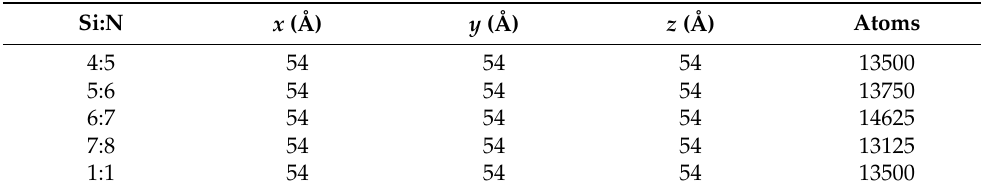
Figure 7. The models of SiN x . ( a ) x = 4/3, ( b ) x =5/4, ( c ) x = 6/5, ( d ) x = 7/6, ( e ) x = 8/7, ( f ) x = 1/1. Table 1. The simulation parameters in SiN x heating process. Si: N